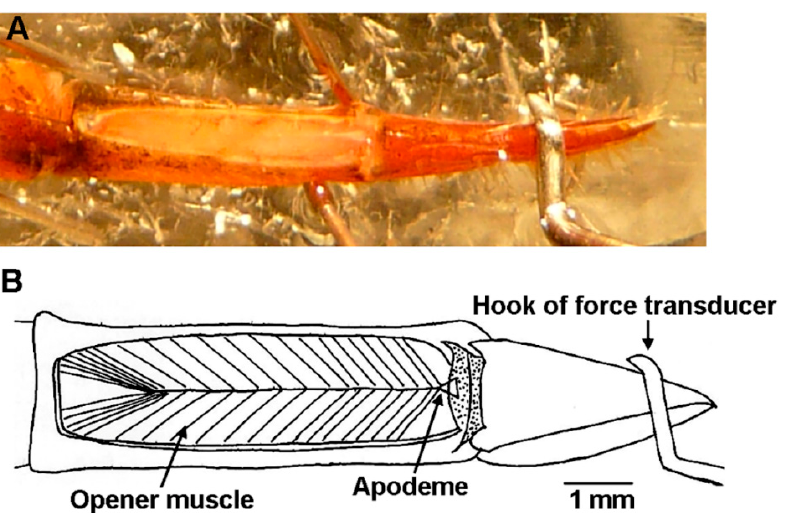
Figure 3. Dorsal dissection of first walking leg with force transducer location: ( A ) Photograph of the first walking leg showing location of the force transducer hook resting on the dactylopodite. ( B ) Diagram detailing anatomy of the preparation showing the pinnate arrangement of the opener muscle and its attachment to the apodeme.